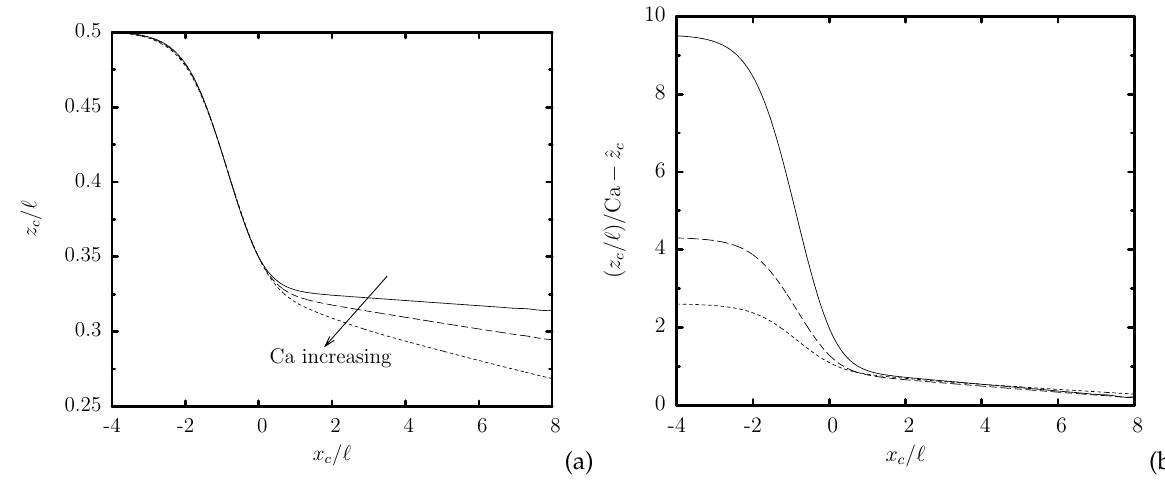
Figure 7. ( a ) The capsule centroid z c as a function of the centroid x c , for a Skalak capsule with a / (cid:96) = 0.8, C = 1, λ = 1, z 0 c / (cid:96) = 0.5 and capillary numbers Ca = 0.02,0.05,0.1. ( b ) As in ( a ) but for the scaled centroid ( z c / (cid:96) ) /Ca subtracted so that the curves have practically the same value at x c / (cid:96) =